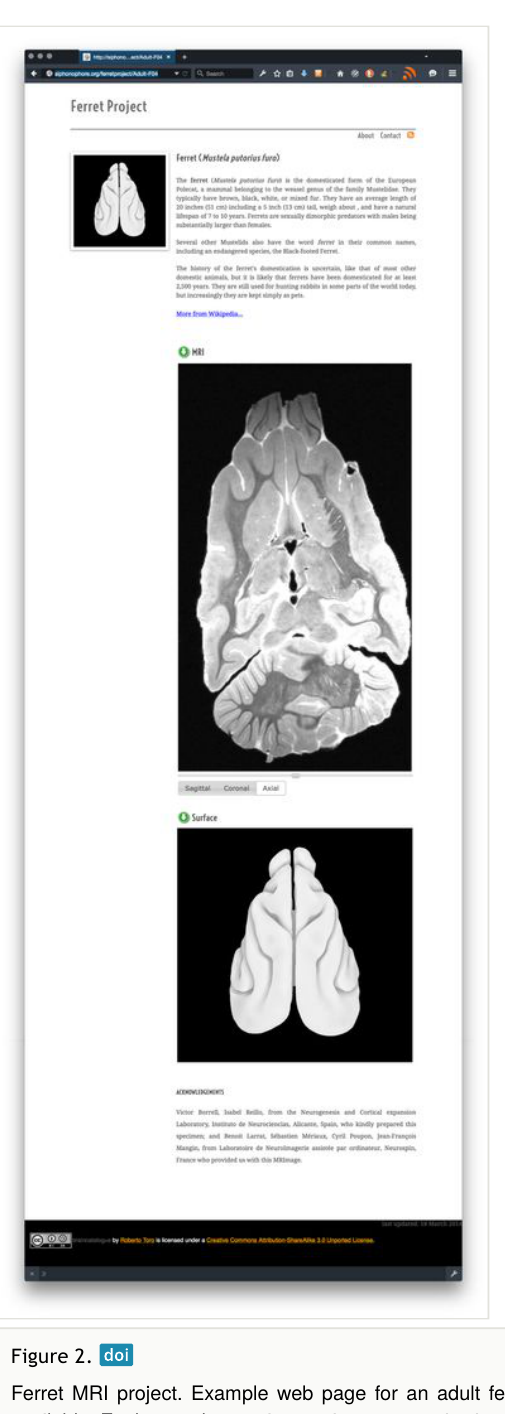
Figure 2. Ferret MRI project. Example web page for an adult ferret brain, out of 24 specimens made available. Each page has an interactive stereotaxic viewer and 3D surface